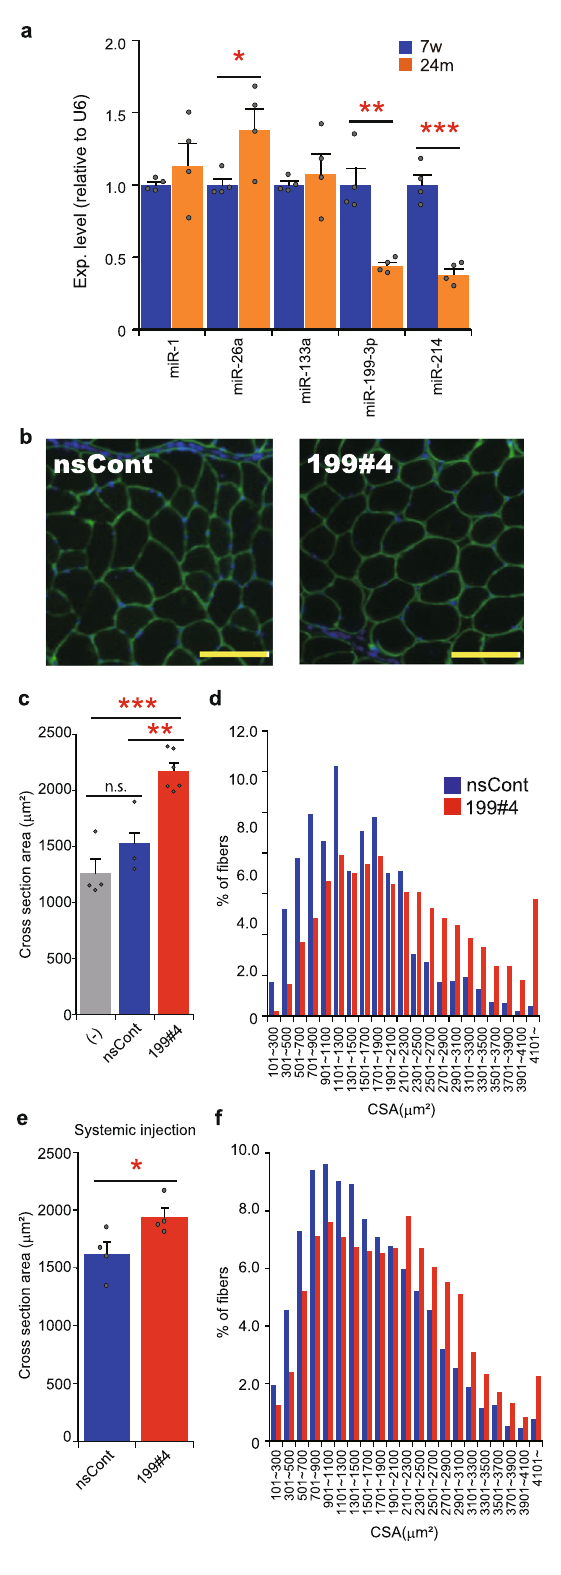
system have provided important insights into aging and rejuvenation 9 – 12 . The fi ndings strongly suggest that there are blood, respectively. Previous studies reported various molecules